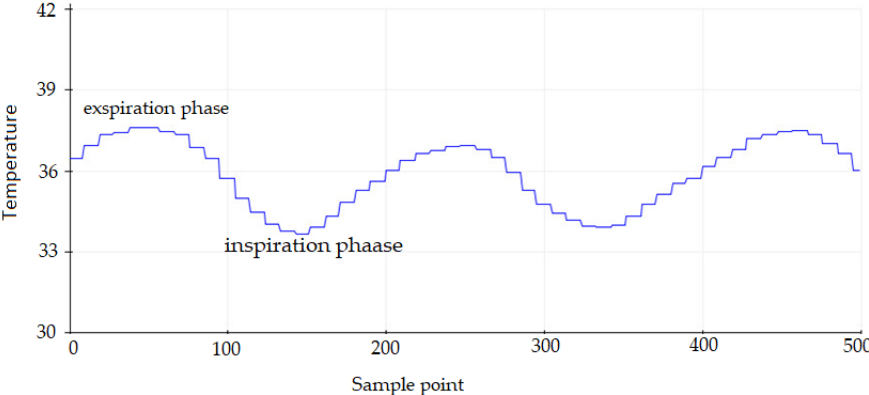
Figure 15. Temperature flowing in the